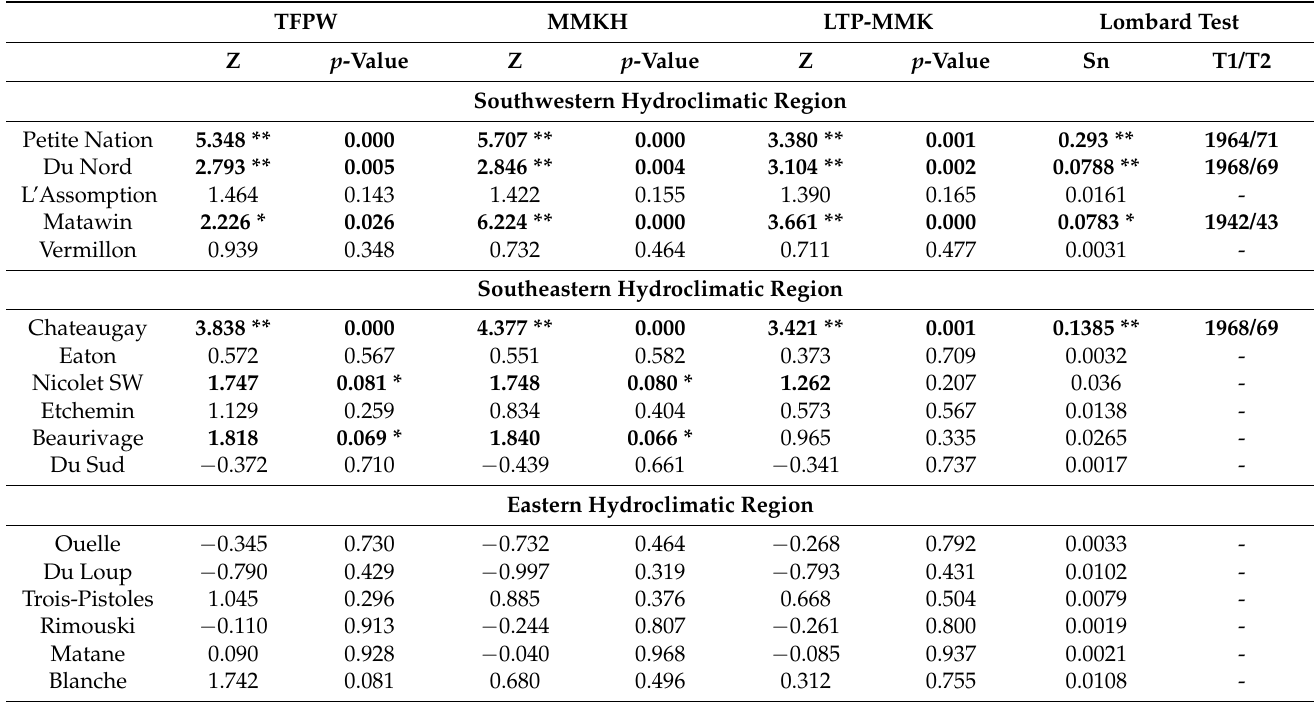
Table 3. Results of the various Mann-Kendall tests applied to the mean annual flows series from 1930 to